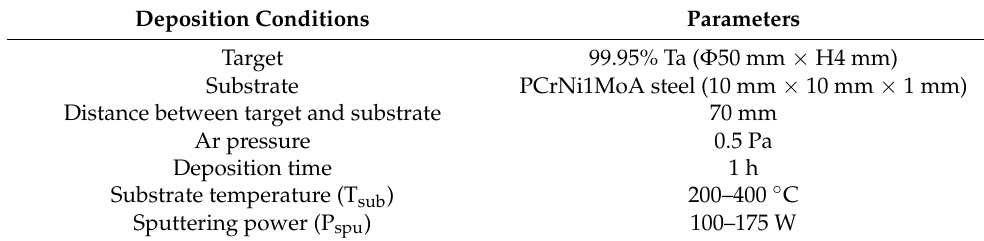
Table 2. Deposition parameters for Ta coatings.